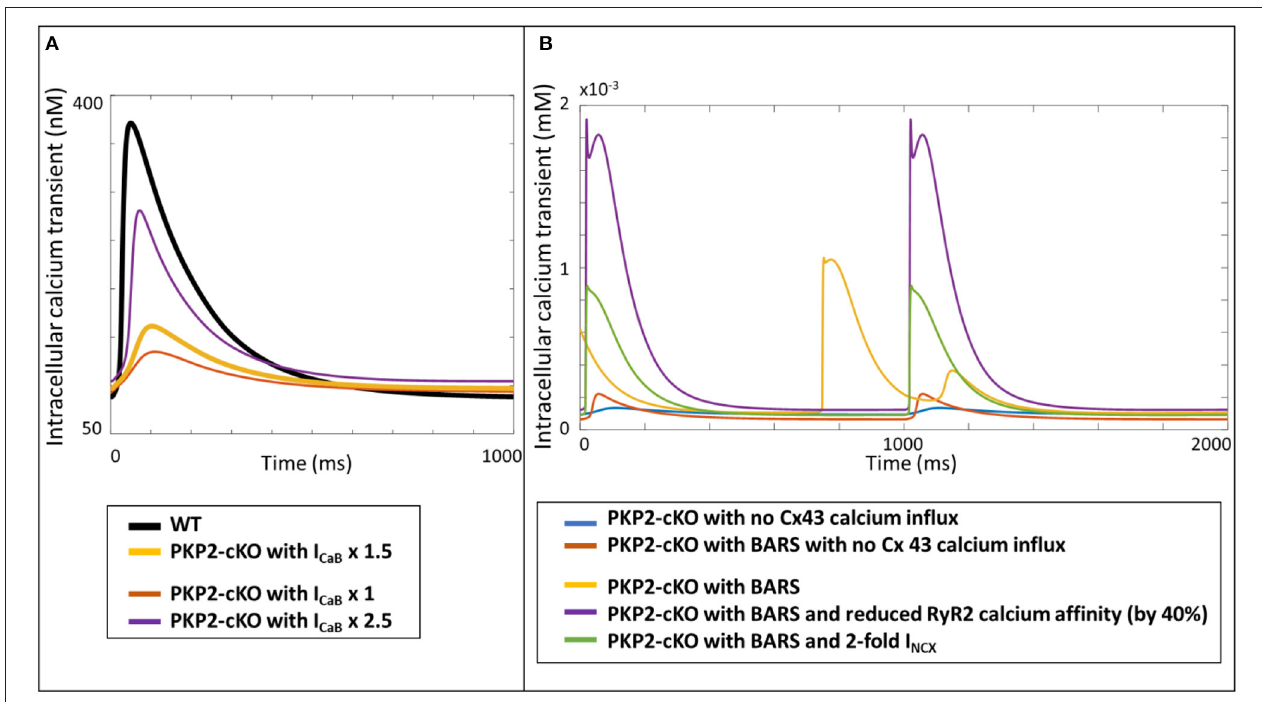
FIGURE 8 | (A) Calcium transients in the human WT, PKP2-cKO and PKP2-cKO model, with various increments of Cx43 hemichannels-mediated calcium entry, applied in the Grandi human ventricular cardiomyocyte model. (B) Calcium transients in the PKP2-cKO model with no Cx43 calcium influx with and without BARS, and PKP2-cKO model plus BARS, RyR2 calcium affinity reduction and increased I NCX